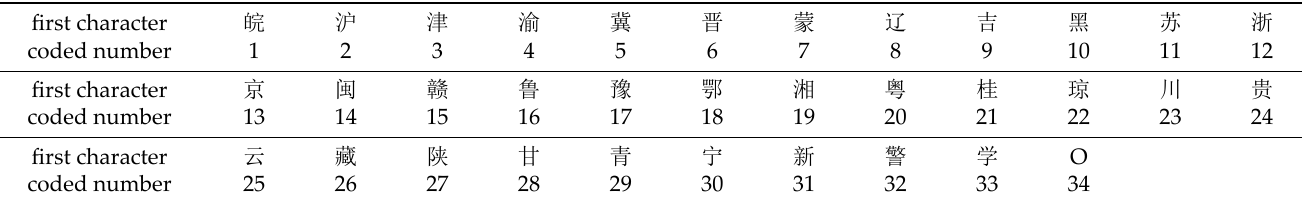
Table 1. Encoding the first Chinese character on the license plate.